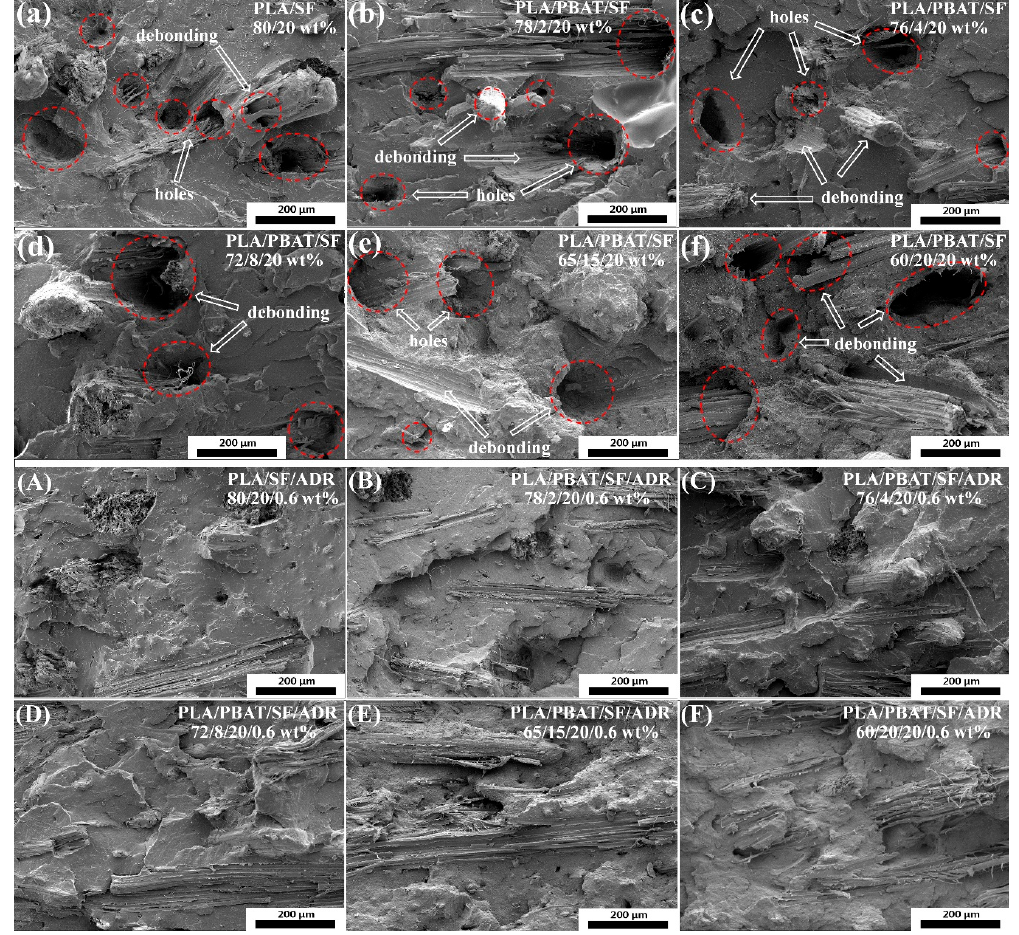
Figure 1. Impact fracture surfaces of polylactic acid/sisal fibers (PLA/SF) composites ( a ); PLA/poly (butylene-adipate-terephthalate)/SF (PLA/PBAT/SF) composites ( b–f ); PLA/SF/commercial grade multi-epoxy-functionalized styrene-acrylic oligomer (PLA/SF/ADR) composites ( A ); PLA/PBAT/SF/ADR composites ( B–F ). 500×